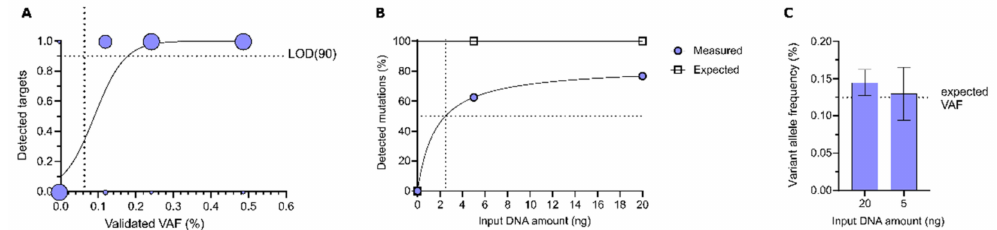
Figure 3. Limit of detection and minimal required input DNA material. ( A ) The number of detected (1) and absent (0) targets for each tested validated VAF across 3 replicates is shown. Circle size corresponds to the number of called variants (max = 60). Data were fitted with a logistic regression. The LOD (90) was determined at a VAF of 0.18%. ( B + C ) Comparison of 0.125% VAF reference standards with 5 ng ( n = 4) and 20 ng ( n = 3) input DNA. ( B ) Percentage of detected verified mutations for both tested DNA amounts. A predicted 50% detection rate was calculated for a DNA input of 2.5 ng. ( C ) Shown are the measured average variant allele frequencies of detected validated 0.125% targets. Dotted line indicates the expected VAF of 0.125%. Data represent mean ± SD ( n = 3).